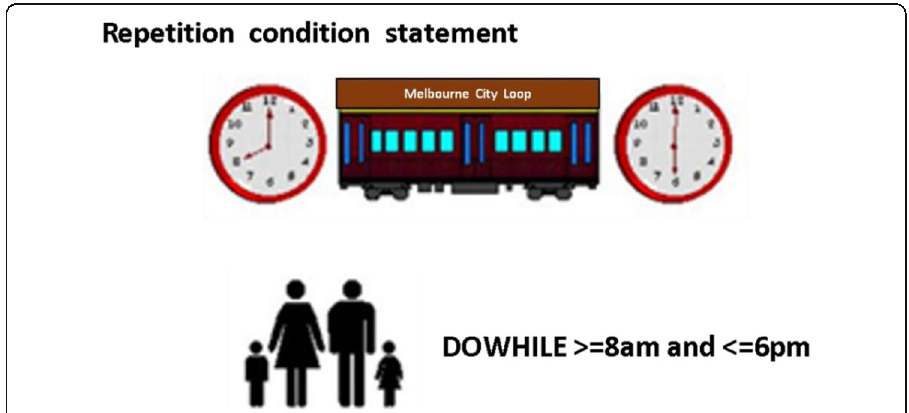
Fig. 5 Text-plus-graphical metaphor (T2) – repetition programming logic (McKay 2000a p.165). This figure represents an example of a text-plus-graphical metaphor for a ‘ do while loop